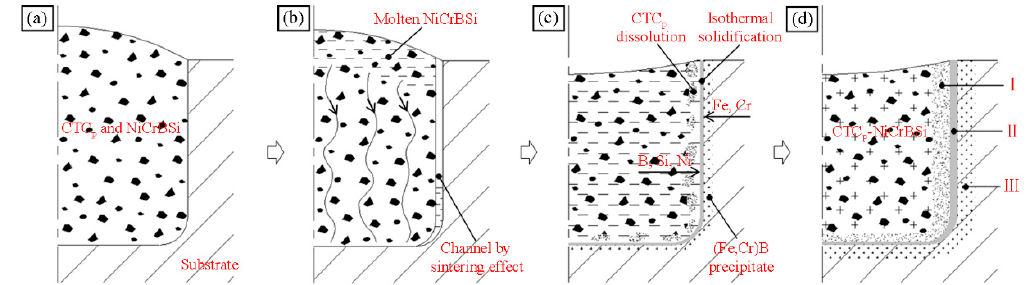
Figure 14. Formation schematic diagram of the interface between CTC P -NiCrBSi and substrate: ( a ) before sintering; ( b ) sintering shrinkage and molten NiCrBSi filling channel; ( c ) elements interdiffusion, CTC P dissolution, isothermal solidification, and (Fe,Cr)B precipitation; and ( d ) interface formation.